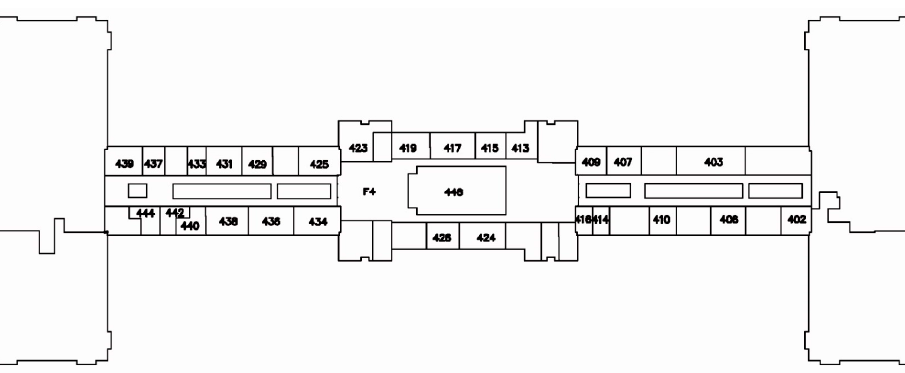
Figure 3. Typical floor plan of project LJ.